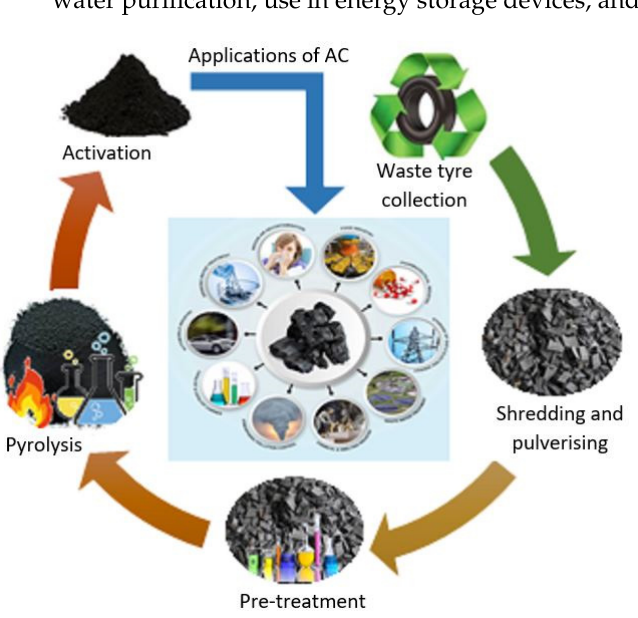
Figure 1. Steps involved in the production of activated carbon from waste tyres.